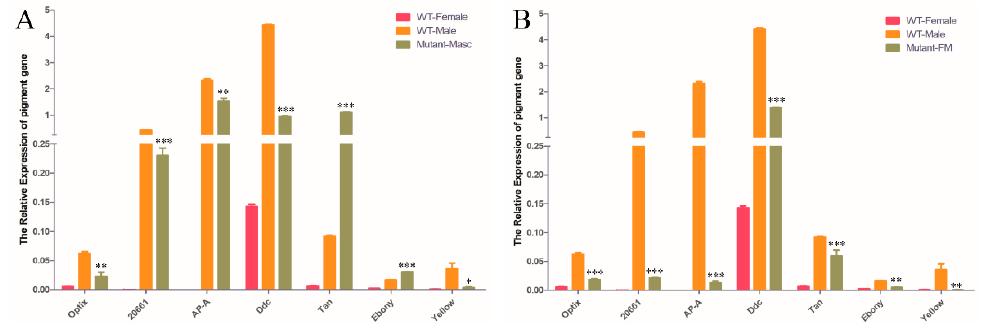
Figure 6. The relative expression of pigmentation genes in OfMasc male mutants ( A ) and Ofdsx FM mutants ( B ). Three individual biological replicates were performed using qRT-PCR. Error bar: SD; n.s., *, ** and *** represent significant differences at the 0.05, 0.01 and 0.001 levels ( t -test) compared with the control.